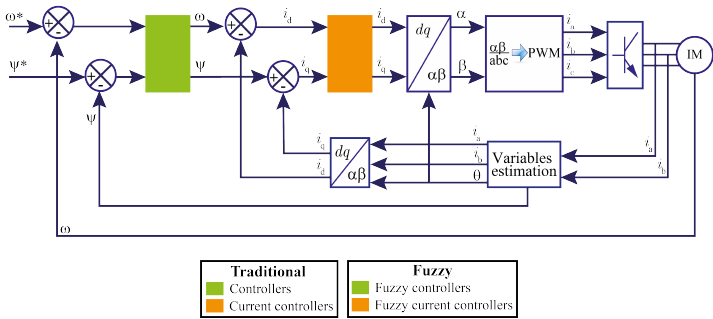
Figure 2. Block diagram of traditional and fuzzy FOC.